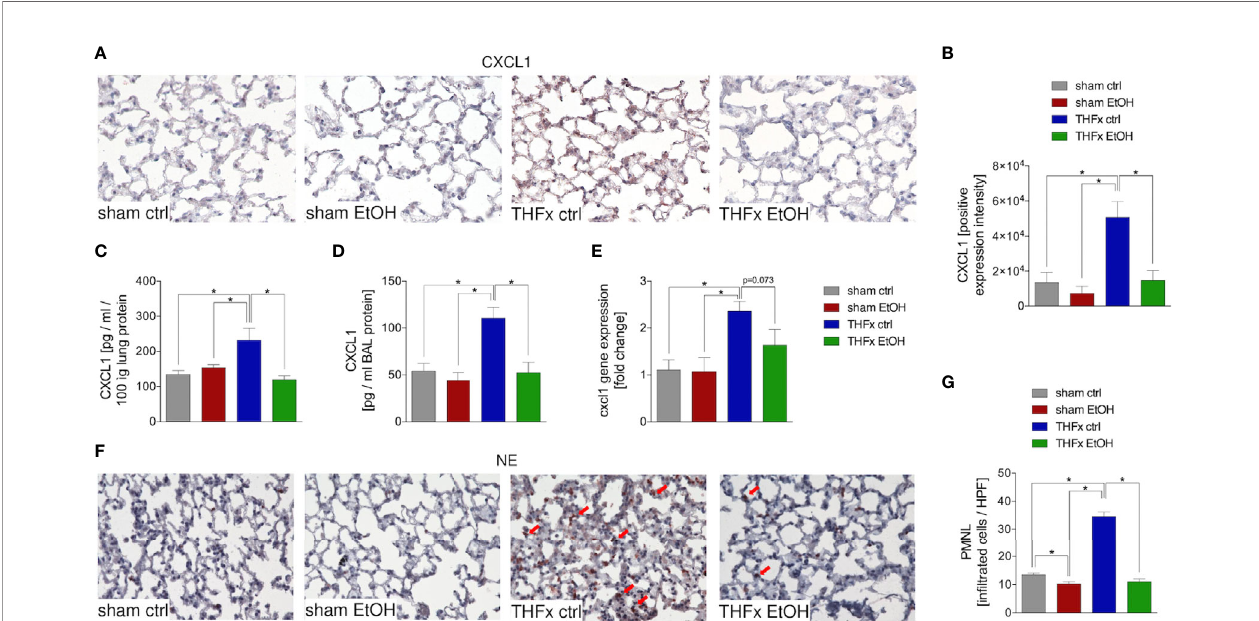
FIGURE 2 | Impact of acute ethanol intoxication (EI) onCxcl1gene andCXCL1protein expression andneutrophilic in fi ltration after femoral fracture (Fx) and hemorrhagic shock (HS). The animalsreceived an intragastric gavage of either sodium chloride(ctrl, n = 14)or ethanol (EtOH, n = 14) to simulate an acute intoxication with alcohol. Two hours before the initiation of experiments, the animalsintrauma groups underwent an Fx( via osteotomy after the placement of an external fi xator)and a pressure-controlled HS with subsequent resuscitation with Ringer ’ s solution (THFx) via catheterized femoral artery( n = 14).Sham groups underwent catheterization andreceived an external fi xator,but THFx was not induced ( n = 14). Twenty-four hours after the end of the experiment, mice were euthanized,and samplingwas performed. (A) Representative lung sectionsupon the stainingof CXCL1in the sham ctrl, sham EtOH, THFxctrl, andTHFxEtOH groups areshown. (B) Quanti fi cation ofCXCL1-positivelystained cellsper high- power fi eld (HPF)isshown. (C) Quanti fi cation ofCXCL1protein concentration inlungtissue homogenates usingmouse-speci fi c ELISA kits isshown. (D) Quanti fi cation of CXCL1protein concentration inbronchoalveolar lavage (BAL) fl uid isrepresented. Brie fl y, to obtainBAL, via trachea, lungs were fl ushed with 1.1 mlof phosphatebuffered saline and then 800 µl was withdrawn for the determination oftotalprotein concentration. (E) RT-qPCR with homogenized lungtissue for Cxcl1 gene expression analyses is depicted. The relative gene expression of Cxcl1 normalized to Gapdh was calculatedby usingthe comparative threshold-cycle2 − DD CT method. (F) Representative immune histological stainingof neutrophilelastase (NE) as a marker ofpolymorphonuclear leukocytes (PMNLs)in lungsectionsisrepresented. Red arrows indicate NE-positively stainedcells. (G) Quanti fi cation of NE-positivelystained cellsper high-power fi eld (HPF) isshown. Data are presented as mean ± standard errorofthe mean; n = 7 inall groups, * p < 0.05 between